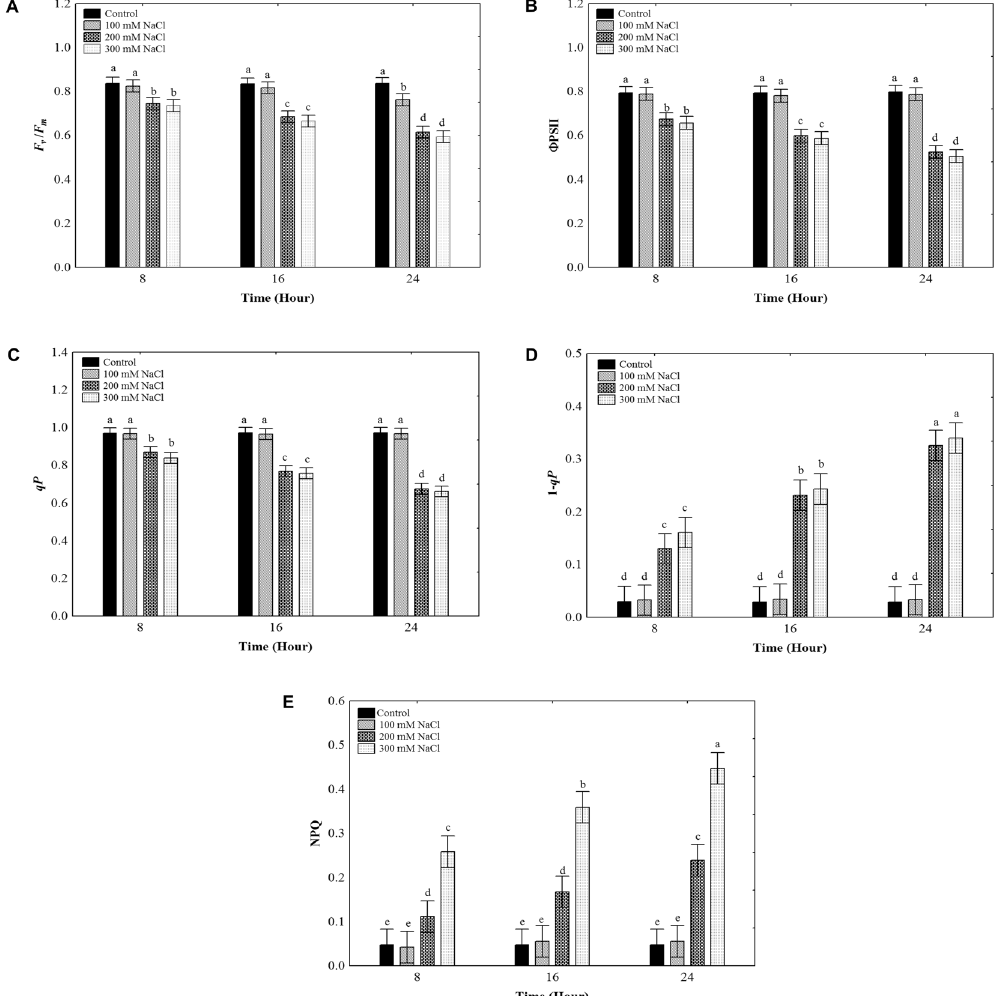
Figure 1. Chlorophyll fluorescence parameters in Opuntia streptacantha cladodes under salt treatments. ( A ) The maximum quantum yield of PSII ( F V / F m ). ( B ) The effective photochemical quantum yield of PSII ( Φ PSII). ( C ) The photochemical quenching ( qP ). ( D ) The excitation pressure (1– qP ). ( E ) The non-photochemical fluorescence quenching (NPQ). Values are means and bars indicate ± SD, ( n = 9). Different letters indicate significant difference between treatments and time (hours) according to Duncan’s multiple range tests at P <